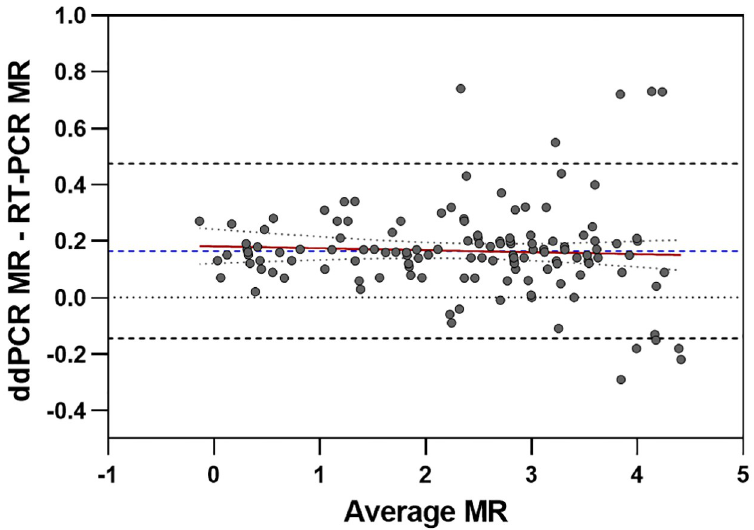
Fig 5. Bland-Altman plot of the 139 evaluable paired samples. The mean bias (95%CI) is shown as a dashed blue line, the limits of agreement are represented by dashed grey lines. The slope of the regression line is indicated by a solid red line.